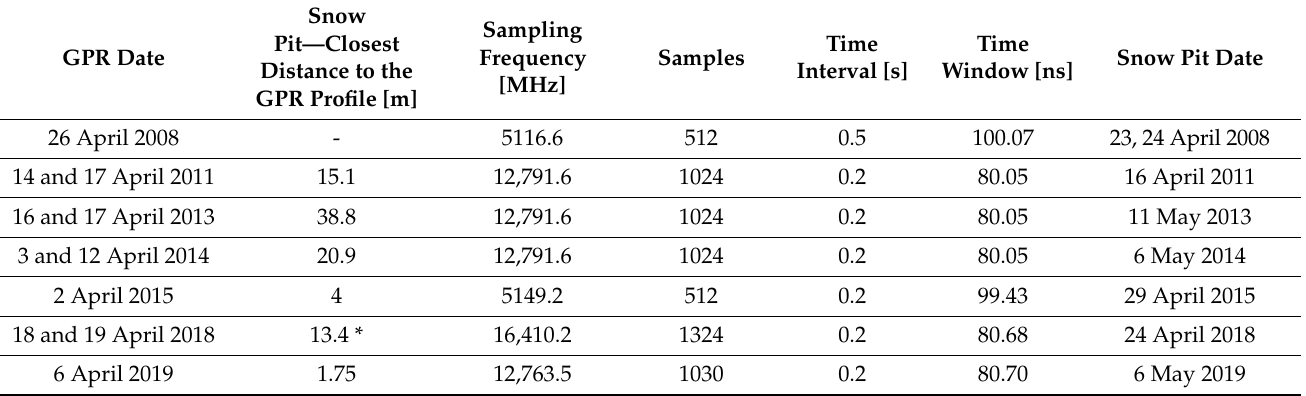
Table 1. Details of GPR surveys and snow pit digging